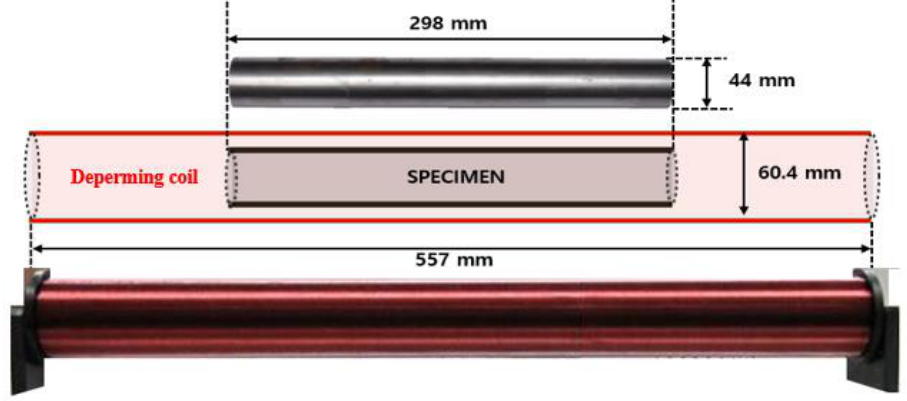
Figure 8. Model of the demagnetization experiment and simulation.